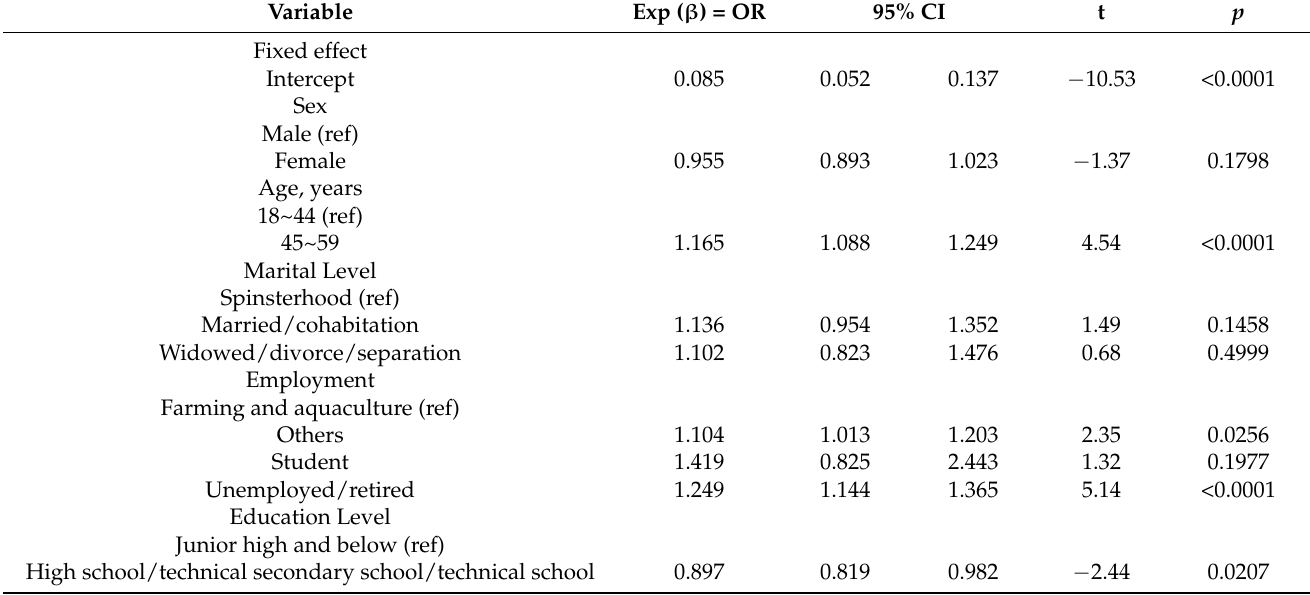
Table 4. Fitting results of two-level multi-factor logistic